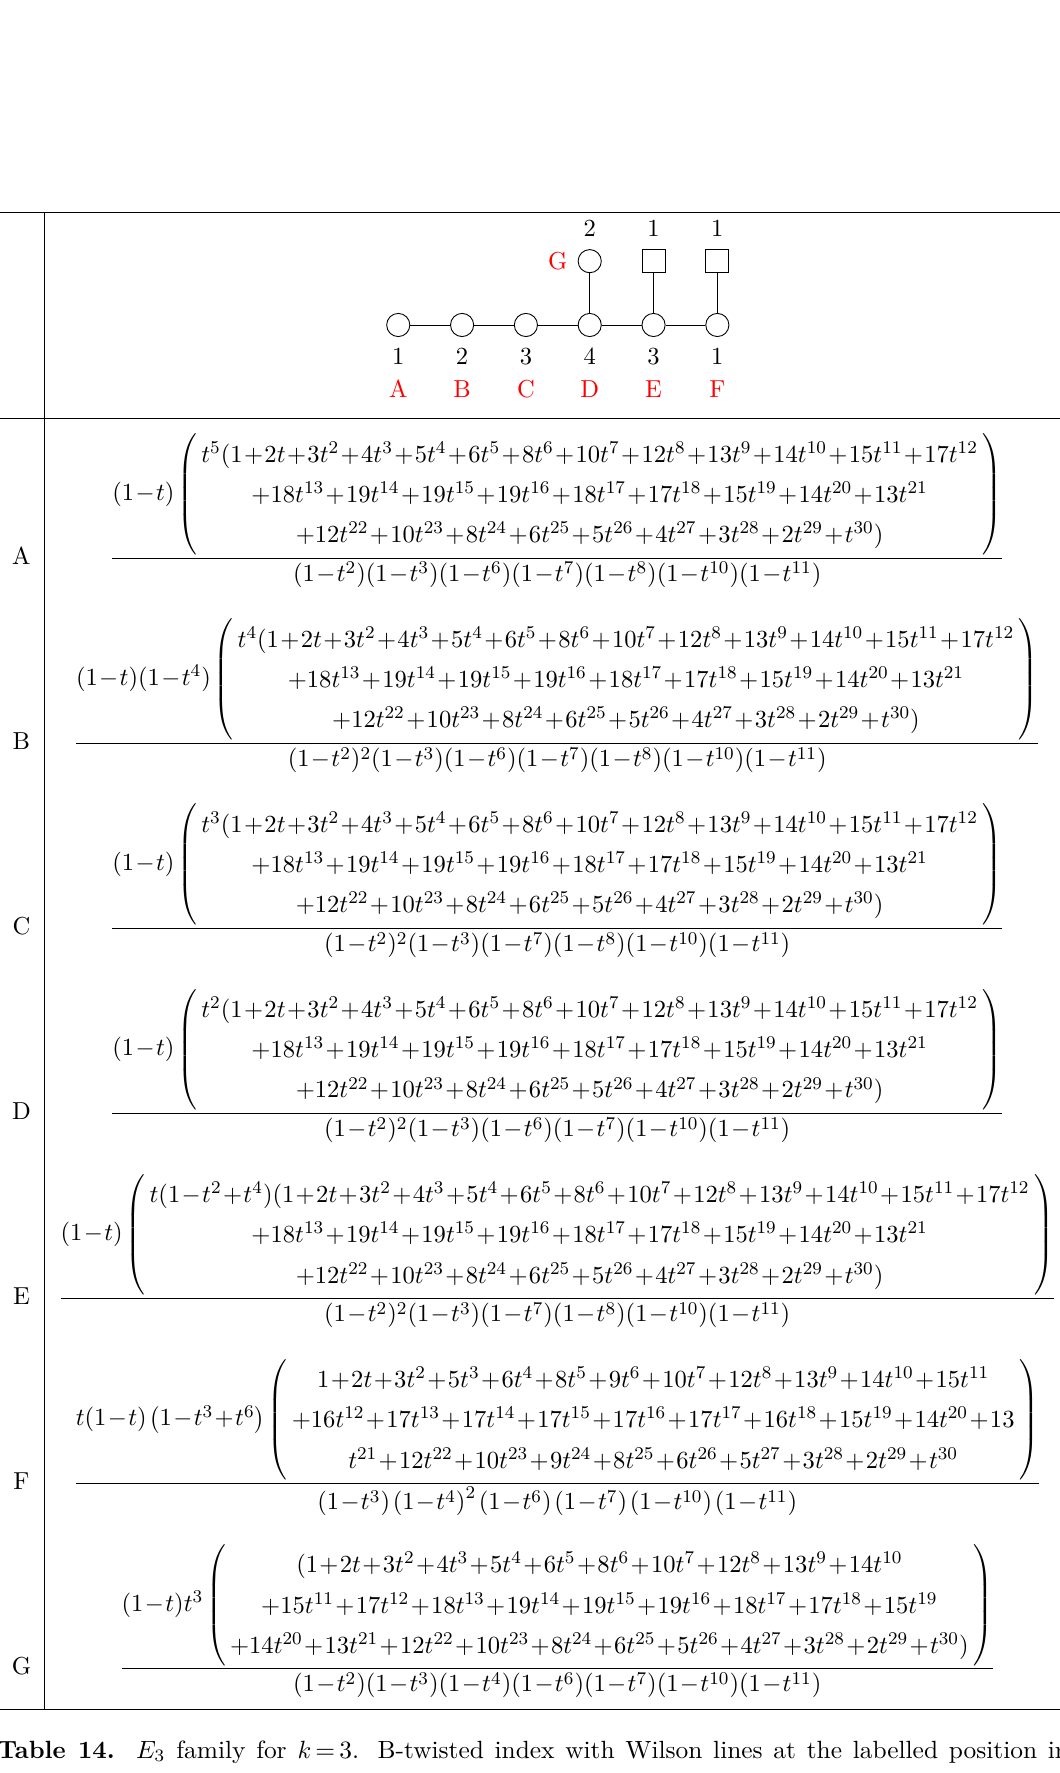
Table 14. E 3 family for k = 3 . B-twisted index with Wilson lines at the labelled position in the